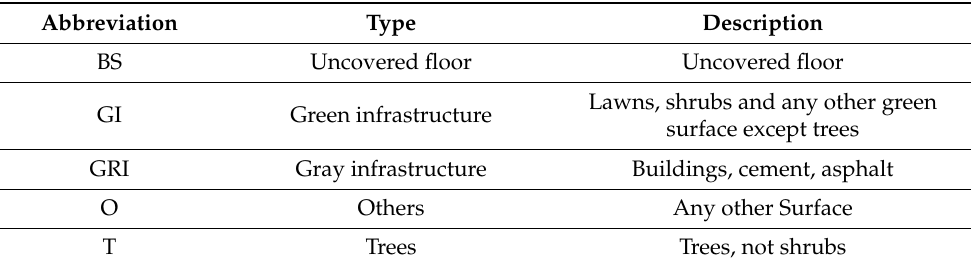
Table 1. Description of selected categories for geospatial analysis of vegetation cover by iTree canopy. Source: Own